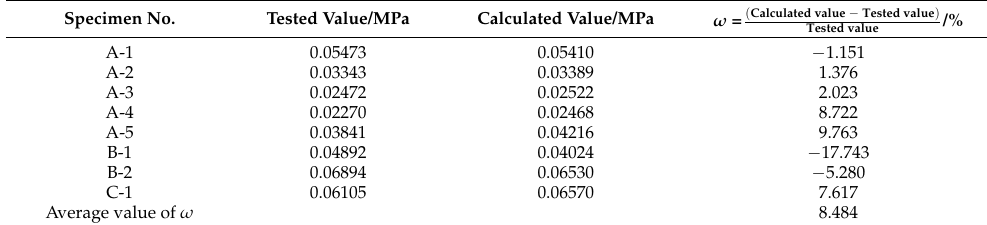
Table 6. Tested and calculated values of ultimate compressive